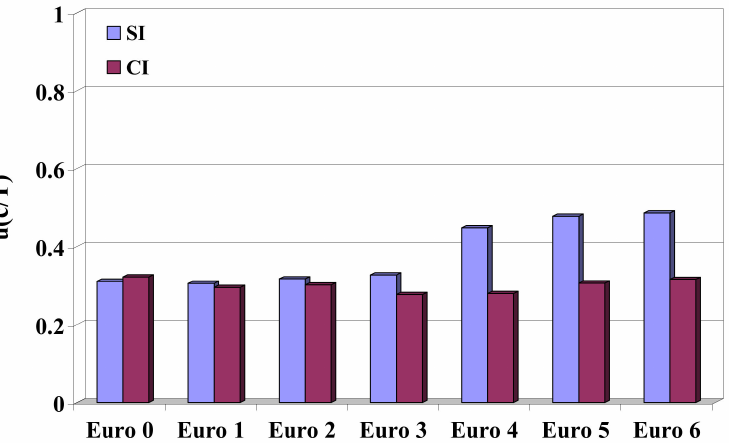
Figure 21. Share of additional carbon dioxide emission in total emission—u(c/T), from passenger cars of pollutant emission categories Euro 0–Euro 6, during warm-up of spark-ignition engines—SI and compression-ignition engines—CI, under model vehicle traffic